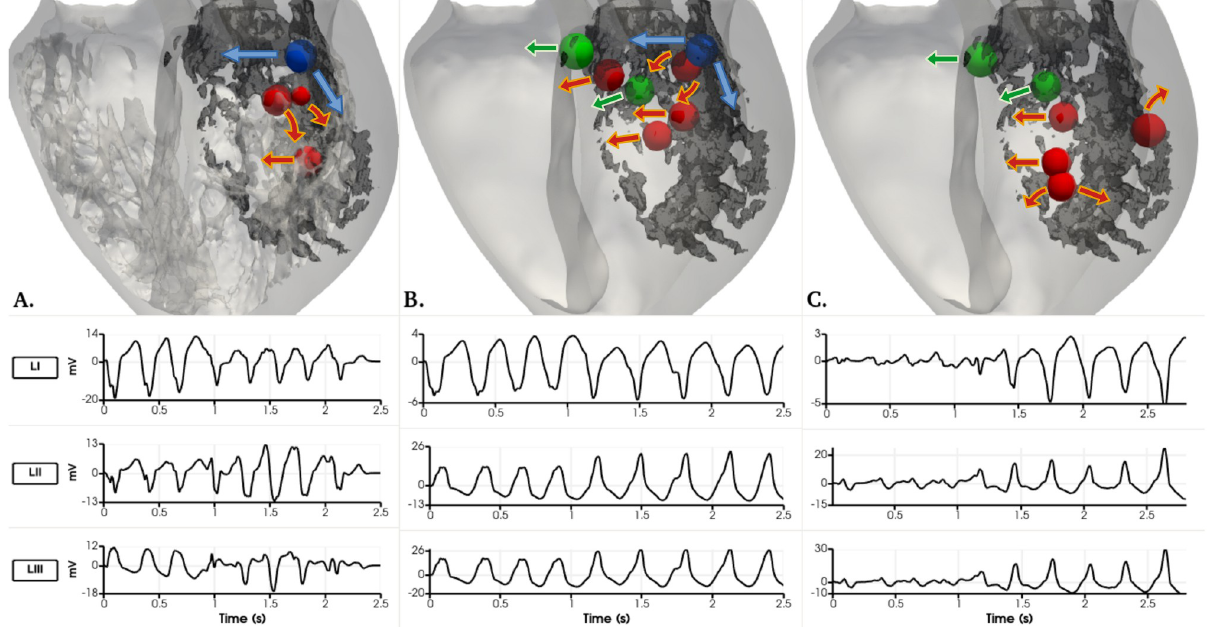
Fig 12. Detailed and smoothed male VT simulations. The dense scar is seen in dark grey colour on all three geometries for reference. View from the mid longitudinal plane towards the posterior side of the heart. Arrows show the propagation wavefront of each reentry. A) Four reentry channel locations on the detailed male geometry with an LV apex stimulation shown as spheres. B) Seven reentry channel locations on the smoothed male geometry with an RV apex stimulation shown as spheres. The blue sphere on A and B corresponds to the same location. C) Six reentry channel locations on the smoothed male geometry with a RVOT stimulus shown as spheres. The green spheres on B and C correspond to the same channel location. Underneath each geometry, the three pseudo-ECG leads recorded for each case.